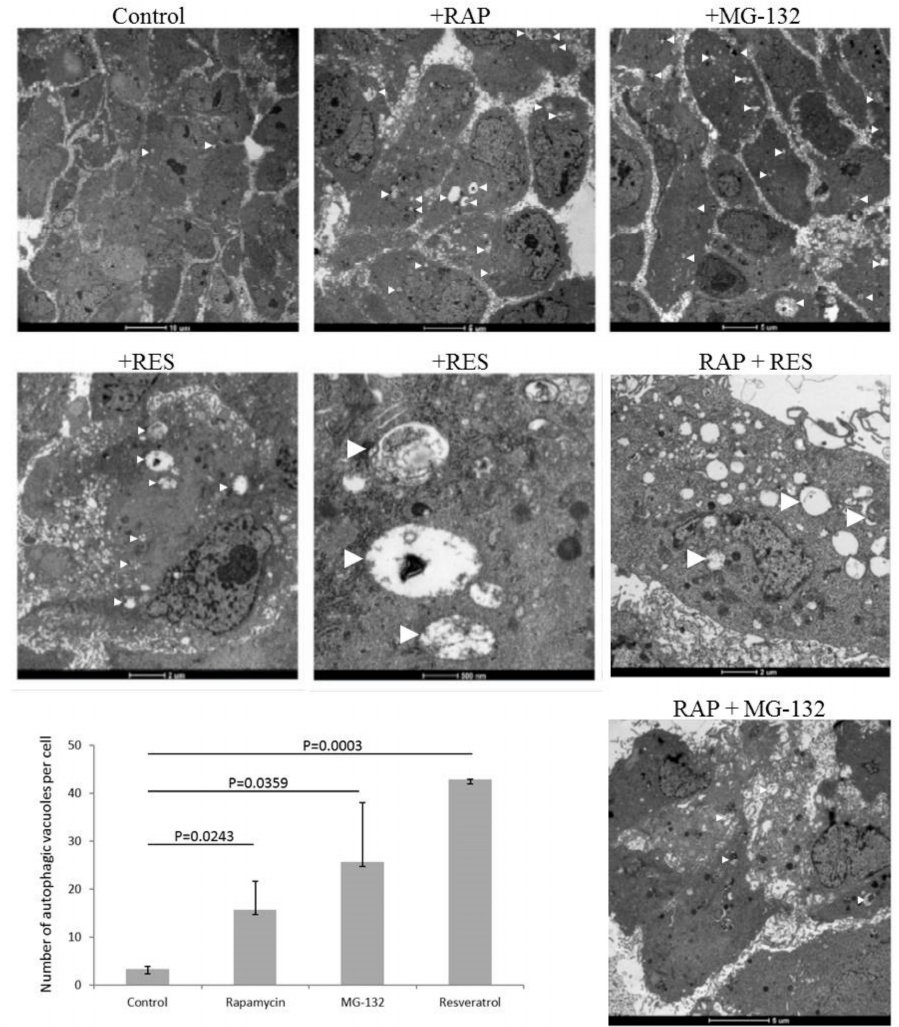
Figure 1. ARPE-19 cell treated by autophagy inducer rapamycin (RAP, 100 nM), proteasome inhibitor MG-132 (100 nM) and resveratrol (RES, 10 µ M) over 24 h. Transmission electron microscopy is shown of ARPE-19 cells under di ff erent treatment modalities. (Bars on the upper panel from left to right: 10 µ m, 5 µ m, and 5 µ m; middle panel from left to right: 2 µ m, 500 nm, and 2 µ m; lower panel: 5 µ m). The number of autophagic vacuoles per cell is shown for the di ff erent treatment conditions. Two-sample t -test was used for the